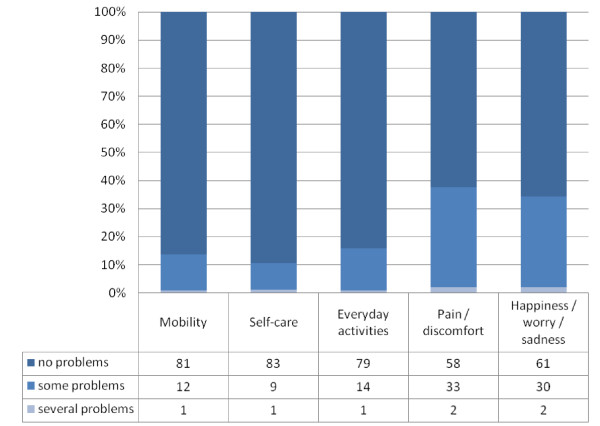
Distribution of EQ-5D-Y dimensions (n = 94).